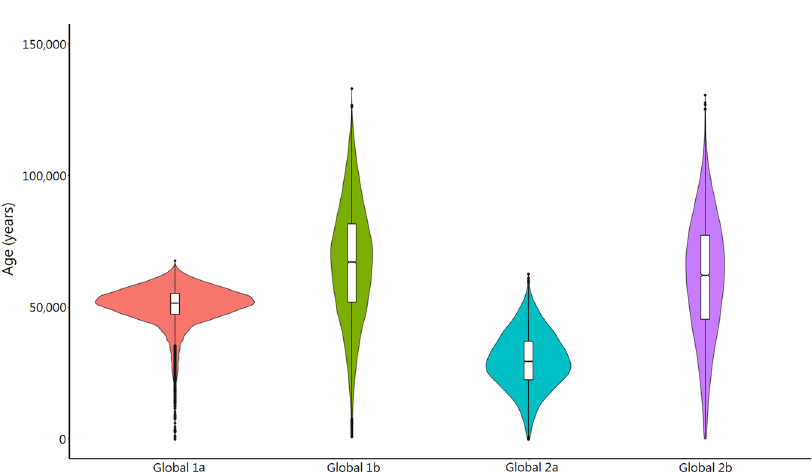
Fig. 4 Violin-boxplots detailing predicted dates for the end of the Acheulean at a global level, derived from 10,000 iterations of the random sampling method. Negative outliers in all models are not